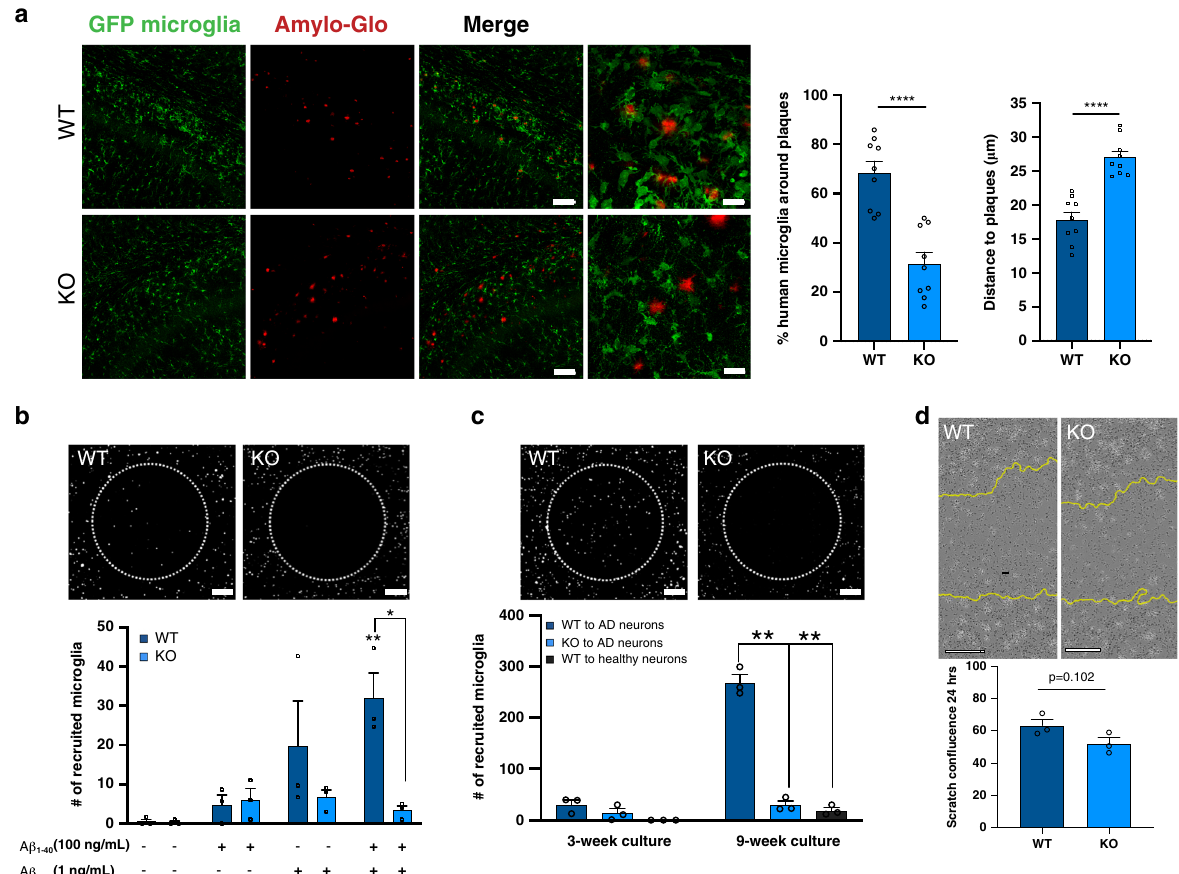
Fig. 4 Deletion of TREM2 reduces the association of microglia with amyloid plaques and impairs migration toward amyloid and AD model cultures. a GFP-expressing TREM2 WT (top) or KO (bottom) microglia xenotransplanted into 5x-MITRG mice and aged 6 mo. were examined to assess the proximity between beta-amyloid plaques (red, Amylo-glo) and microglia (green). Scale bar low power: 40 μ m; high power: 20 μ m. Percent of each genotype within 50 μ m of a plaque and raw distance to closest plaque was quanti fi ed ( t -test **** p < 0.0001, n = 9 individual mice, 4 images per mouse). Darker blue represents TREM2 WT. Data are represented as mean values ± SEM. Experiment was run with two individual patient backgrounds. b In vitro migration of microglia toward soluble recombinant beta-amyloid. Images show microglia plated in outer chambers and allowed to migrate for 4 days through micro fl uidic channels toward beta-amyloid (A β 1 – 40 and A β 1 – 42 ) within the inner chamber (delineated by the dashed circle). Scale bar: 500 μ m. ( n = 3 independent devices, unpaired t -test * p = 0.0114; WT vs WT + A β β p = 0.0076). Data are represented as mean values ± SEM. c WT and 1 – 40 and A 1 – 42 TREM2 knockout microglial migration toward 3-week old A β -producing human neural and astrocyte mixed cultures or toward 9-week old wild type cultures. Scale bar: 500 μ m. ( n = 3 independent devices unpaired t -test ** p < 0.001; WT vs KO p = 0.0078; WT vs WT(AD) vs WT (healthy) p = 0.0063). Data are represented as mean values ± SEM. Experiments from b,c were reproduced with equivalent results in two independent lines. d Scratch wound assay imaged and quanti fi ed 24 h post scratch with IncuCyte WoundMaker revealed no signi fi cant differences in general motility ( n = 3 independent wells with 4 images per well, t -test p = 0.102). Yellow line demarcates original scratch. Data are represented as mean values ± SEM. Experiment was reproduced in three independent lines. Scale bar: 200 μ